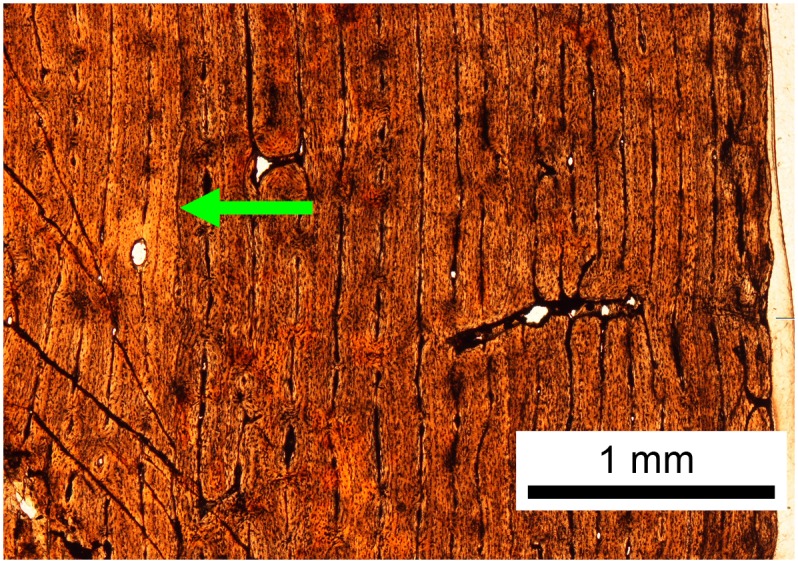
Outer cortical histology of MOR 794 Brachylophosaurus canadensis femur.The right femur (length 129.5 cm) of MOR 794 was histologically sampled using a core of the outer cortex of the anteromedial mid-diaphysis rather than a complete cross-section of the mid-diaphysis, so the complete LAG record was not sampled and the individual’s age in years is unknown. Green arrow indicates the outermost LAG. Cortical surface is on the right.